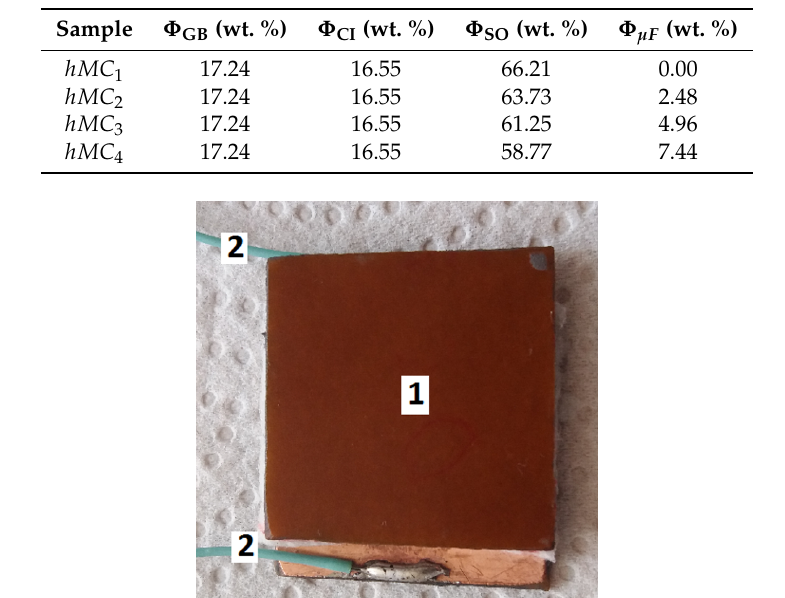
Figure 2. Textolite plates (view of the sides covered with copper)—position 1; hMC—position 2; and, Electrical connections—position 3. Table 2. The mass fractions Φ GB , Φ CI , Φ SO , and Φ µ F of GB, CI, SO, and, respectively, of µ F composing the hMC i , i = 1, 2, 3, 4.